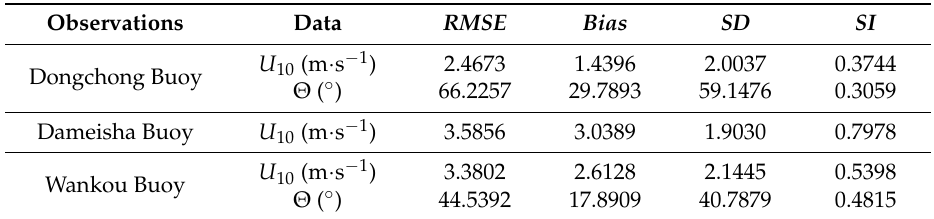
Table 4. Summary of the error indicators for the Typhoon Rammasun simulation. RMSE : root mean square error; SD : standard deviation; and SI : scatter